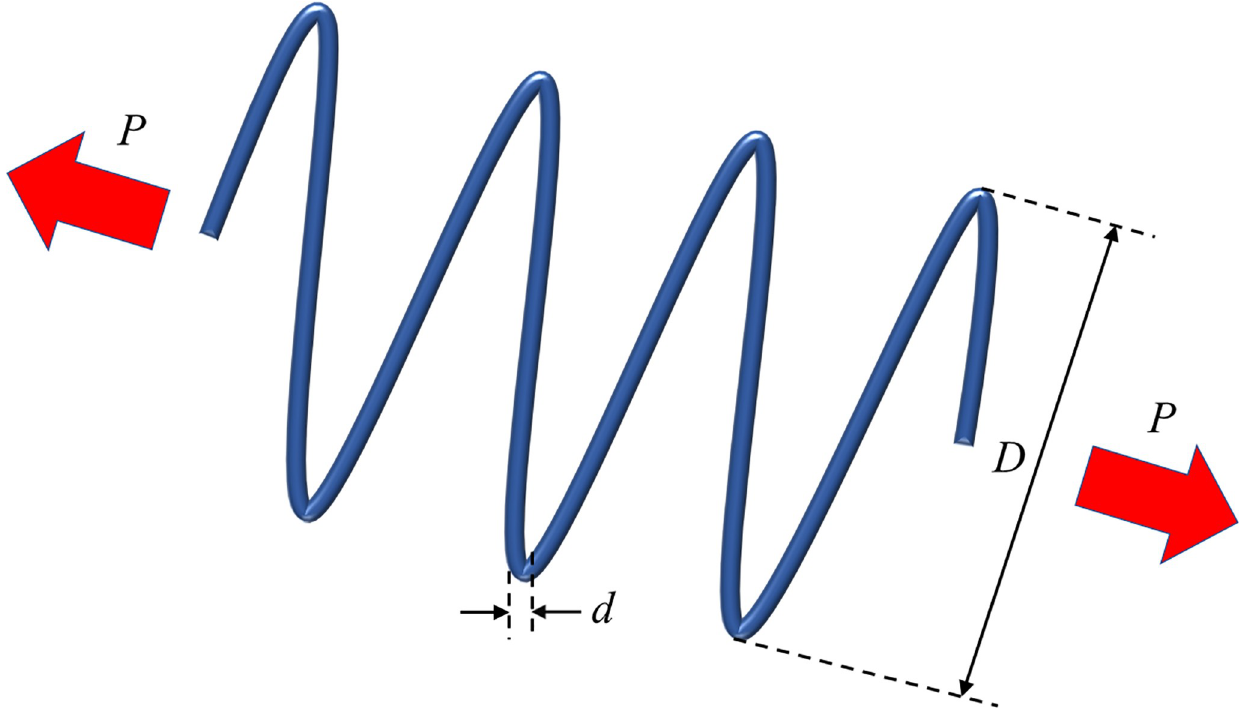
Fig 16. 3D schematic view of the compression/tension spring design problem.